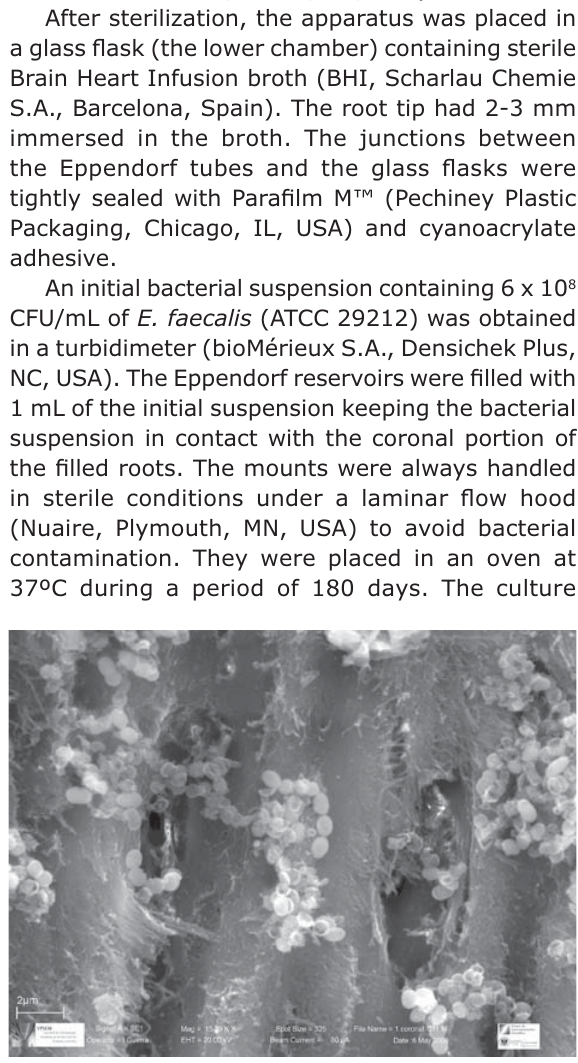
Table 1- Specimens not leaking in the different time periods (initial sample n=15 in each group)